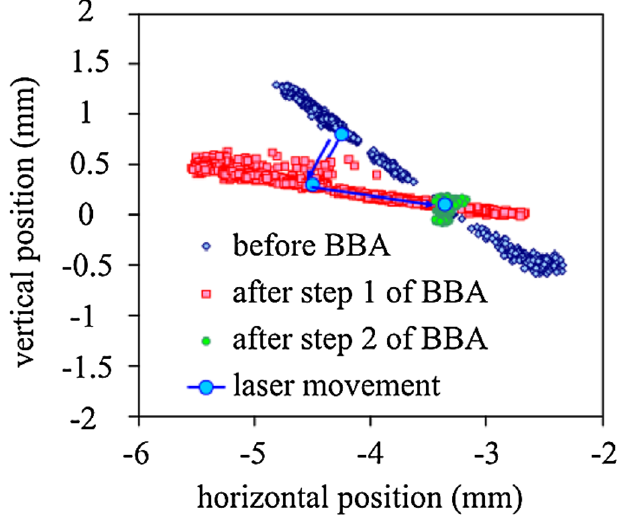
FIG. 21. (Color) Cathode laser BBA: movement of the electron beam center position ( x , y ) on a screen 0.78 downstream of the cathode with a variation of the laser launch phase. The corre- sponding displacement of the laser at the cathode is calculated from its relative positions on the cathode imaging screen and plotted as